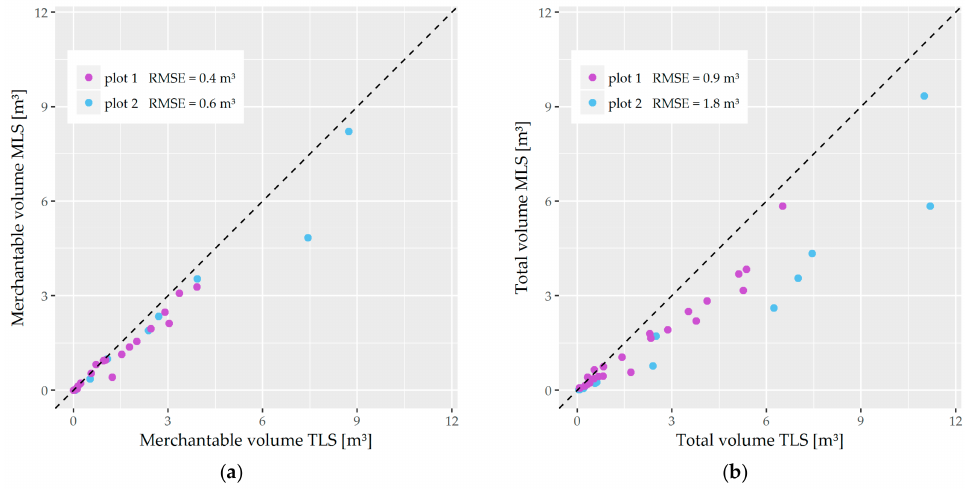
Figure 12. Extracted volume of the QSM cylinders: ( a ) Merchantable volume in (m 3 ); ( b ) Total volume in (m 3